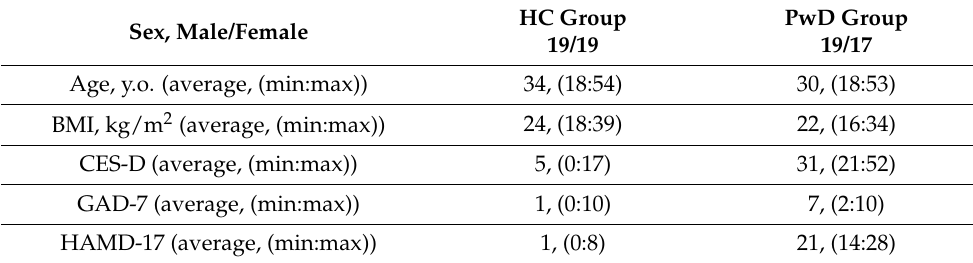
Table 1. Characteristics of the final cohorts for